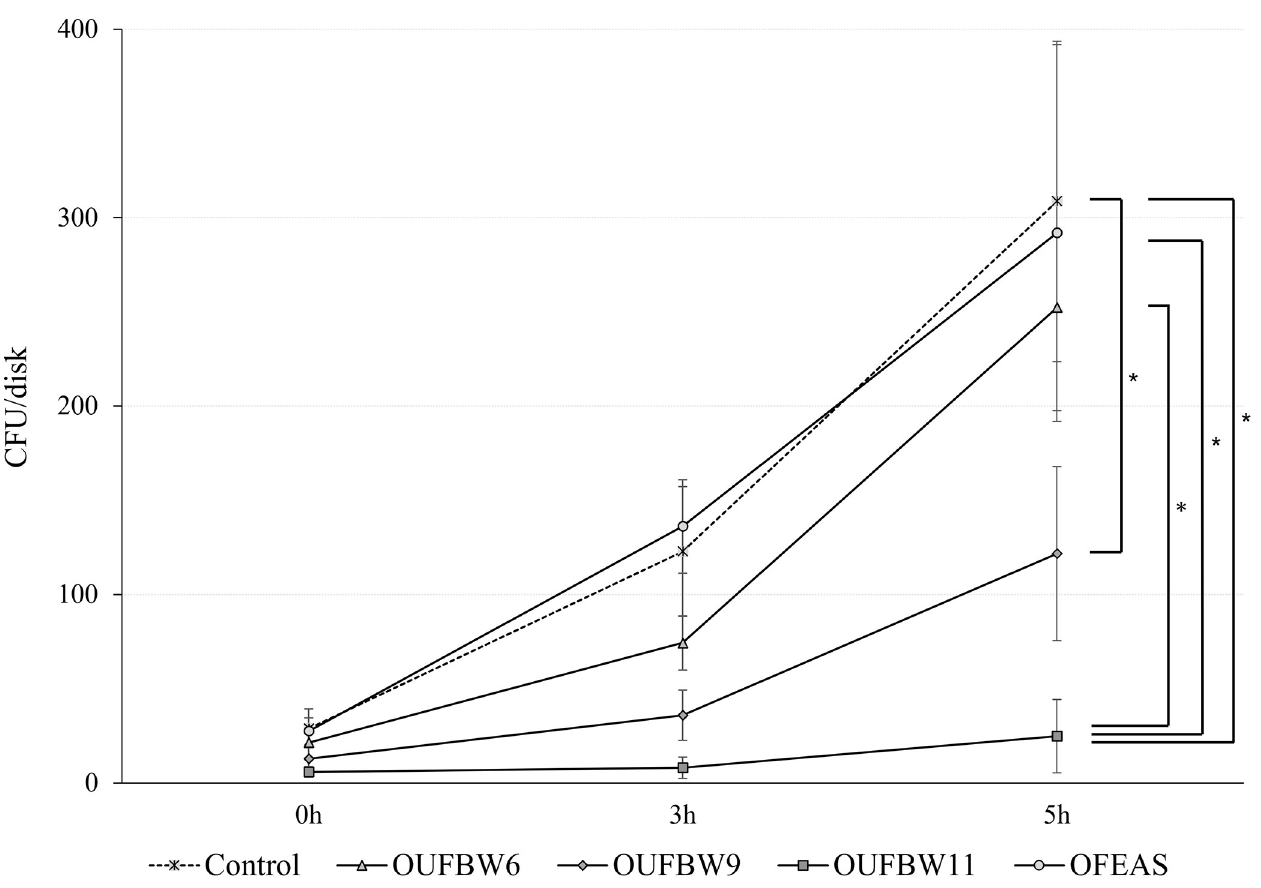
Fig 2. Candida growth assay after immersion of samples. After soaking in the cleaning solution, the samples were cultured in a YNB medium for 0, 3, and 5 h and stamped on Sabouraud agar plates. The number of colonies formed on plates were counted (n = 8 at each time point and, in each group). ( � : p < 0.05).